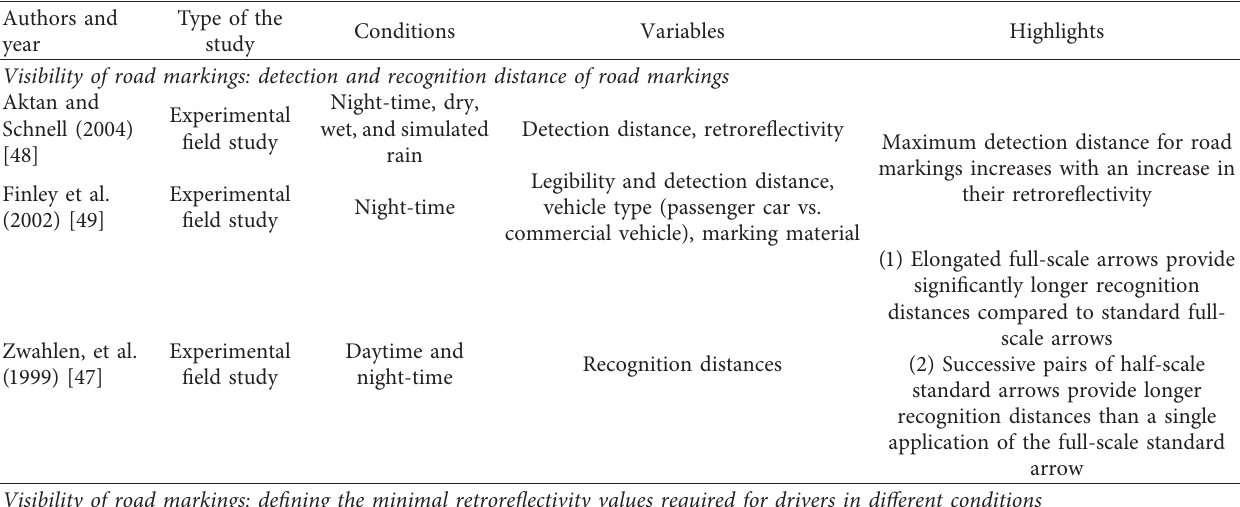
Visibility of road markings: defining the minimal retroreflectivity values required for drivers in different conditions Graham et